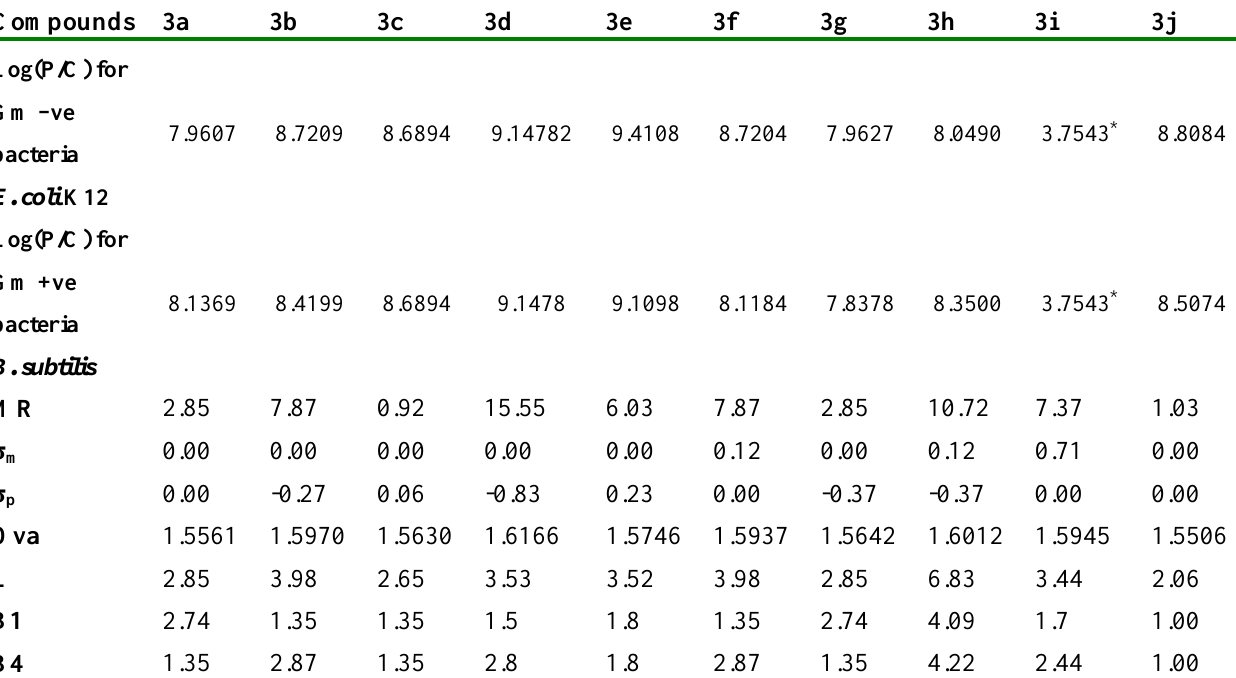
Table 2. Characterization data of 3a-j for the QSAR study.